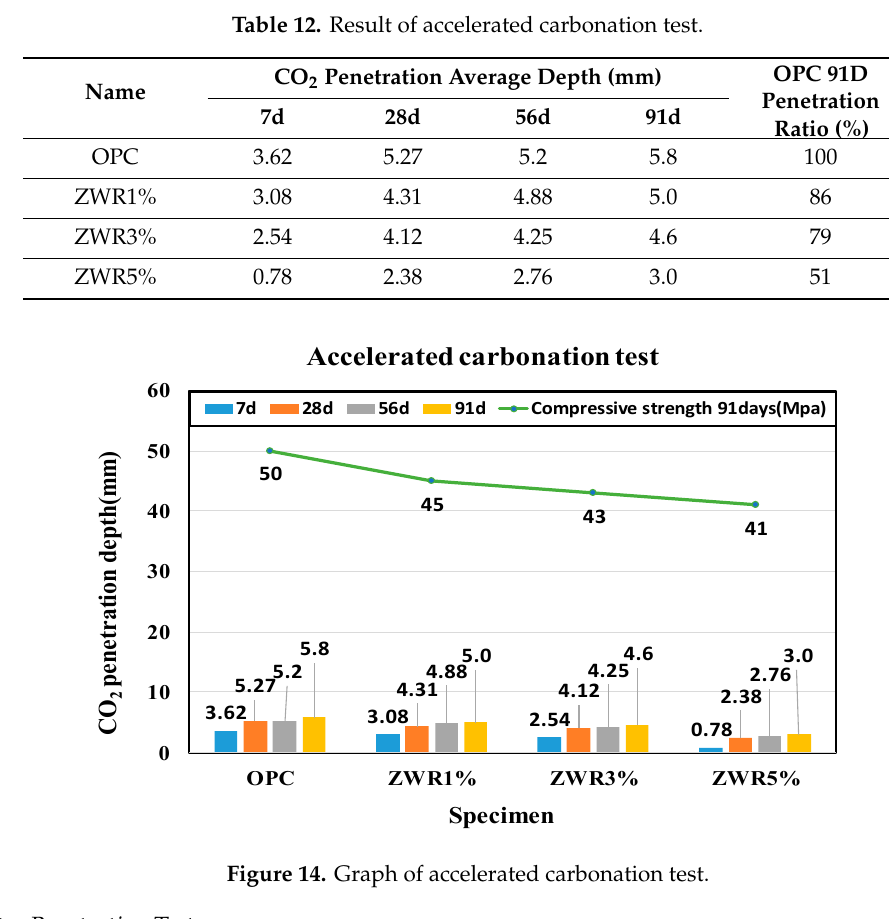
Table 13. Data of accelerated carbonation test (28 days).